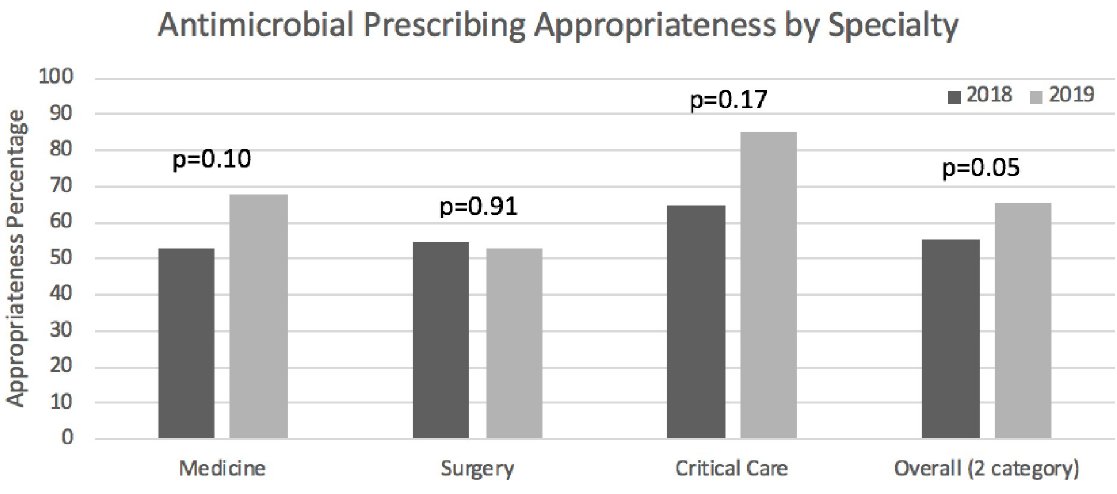
Fig 4. Antimicrobial prescribing appropriateness by